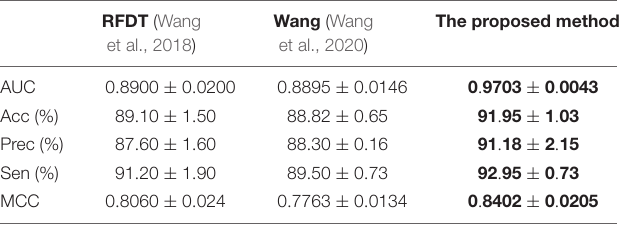
by averaging every word over the length dimension of the drug. (3) Representing drug with